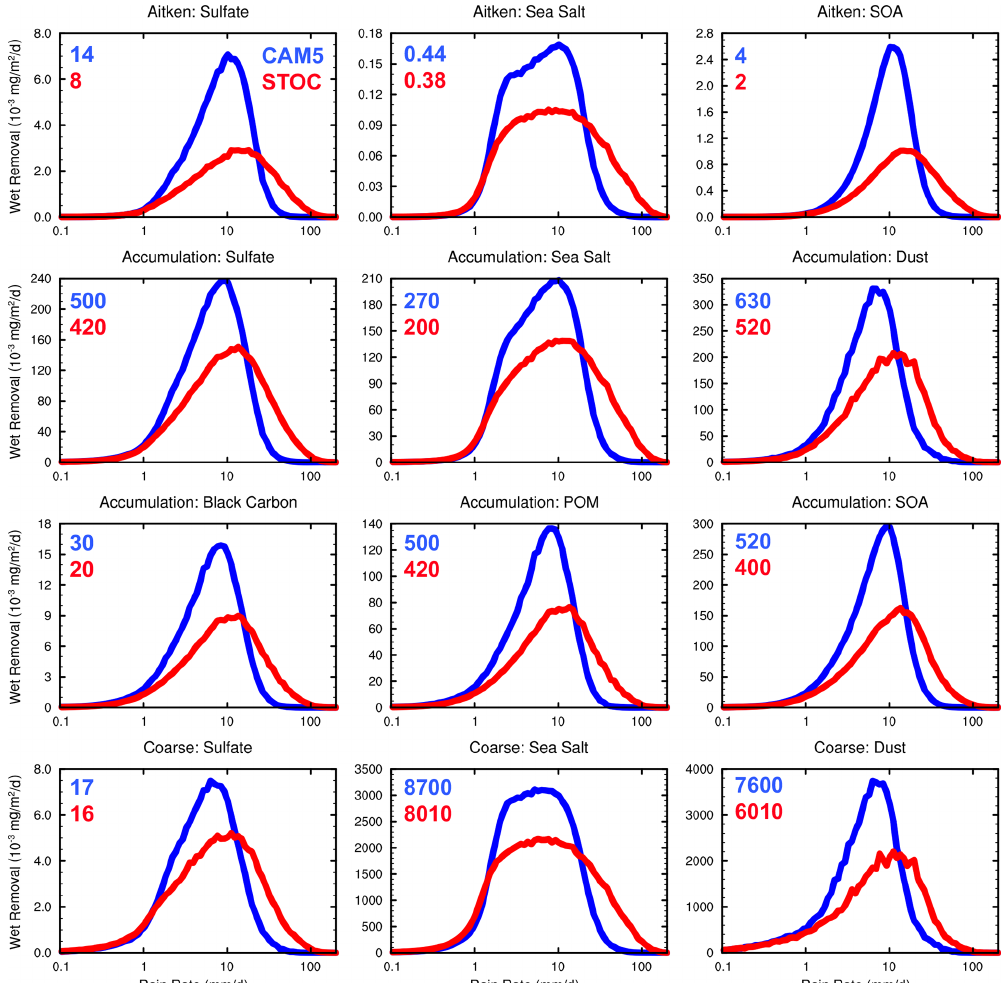
Figure 4. Amount distributions of wet removal of aerosols (units: mg/m 2 /day) over 20 ◦ S, 20 ◦ N in CAM5 (blue) and STOC (red) runs. The distributions are scaled by (cid:49) ln (R) = (cid:49)R/R , which has units ofmmd − 1 /mmd − 1 and is a unitless scaling term. Numbers in each subplot are regional mean wet deposition rates in two simulations. Note that the y -axis range for each frame is